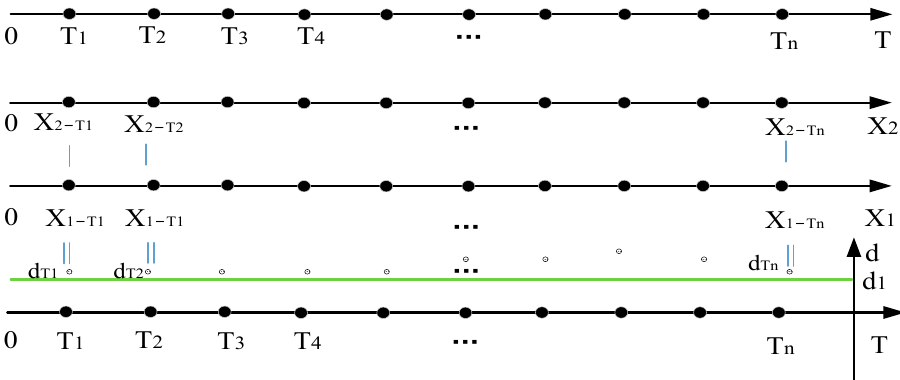
Figure 8. Real-time distance of the end-effector of the manipulator in the horizontal direction. By analyzing the distance between the ends of the two manipulators at the same time node in the target tracking trajectory in the direction of movement of the conveyor belt, it is possible to determine whether there is a conflict between the manipulator’s arms during sorting, as well as the type of conflict and the time node where the trajectory conflict is located. As is shown in Figure 8, if the real-time distance d Ti between multiple manipulators is above d Ti on all real-time nodes, there is no conflict between the manipulators; if there is a node where the implementation distance d Ti is between d 1 and the timeline, there is a trajectory conflict, and the conflict can be eliminated by controlling the speed of the manipulator at this time node; if there is a node where the implementation distance d Ti is below the timeline, there is a task conflict and the conflict cannot be eliminated. The movement direction of the manipulator and the task priority of the robotic arm redefine the